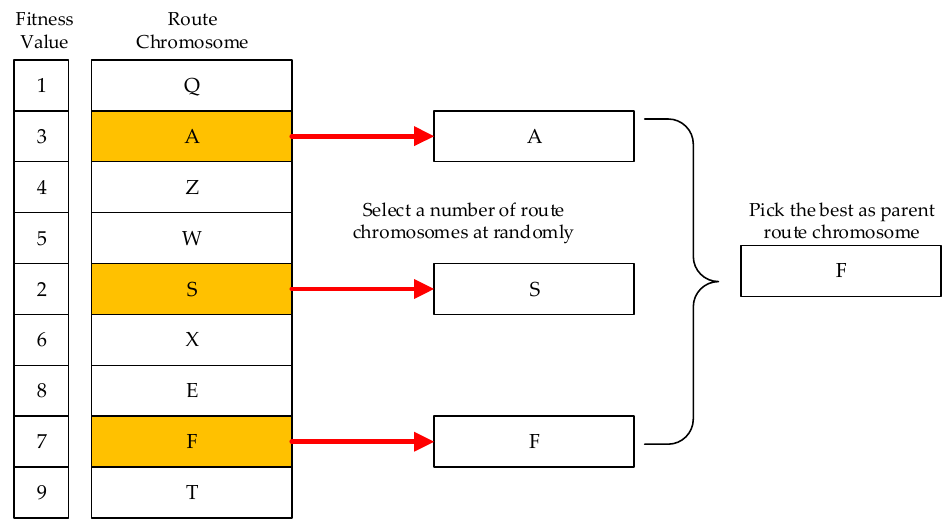
Figure 7. Tournament selection on population.